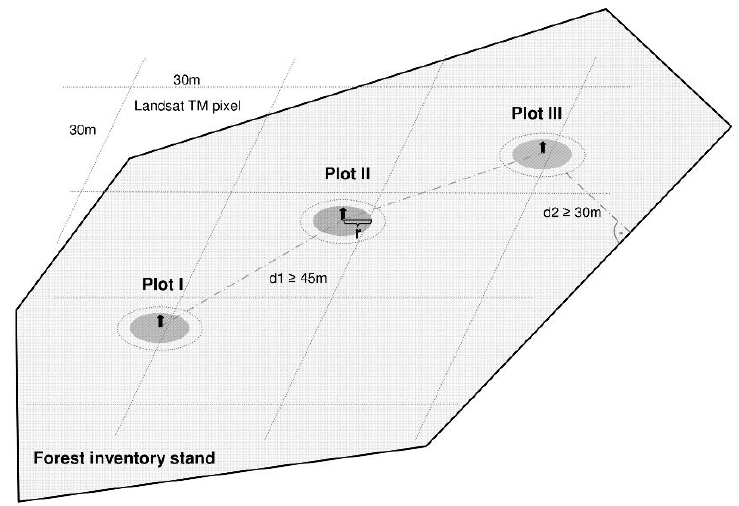
Figure 2. Sample design and field data collection. 105 even-aged spruce plantation stands were randomly selected from stand-based inventory (SBI) districts and re-sampled based on a simplified procedure of the Polish Forestry Service. Sample design for every selected stand based on three plots. The first plot—as a representation of general stand homogeneity/heterogeneity—was localized in the core part of the stand. Two further representative plots were then localized along a transect, at a min. 45 m distance (d1) from one another, which brought us deeper into the stand. Additionally, every plot was located at a min. 30 m distance (d2) from the stand’s